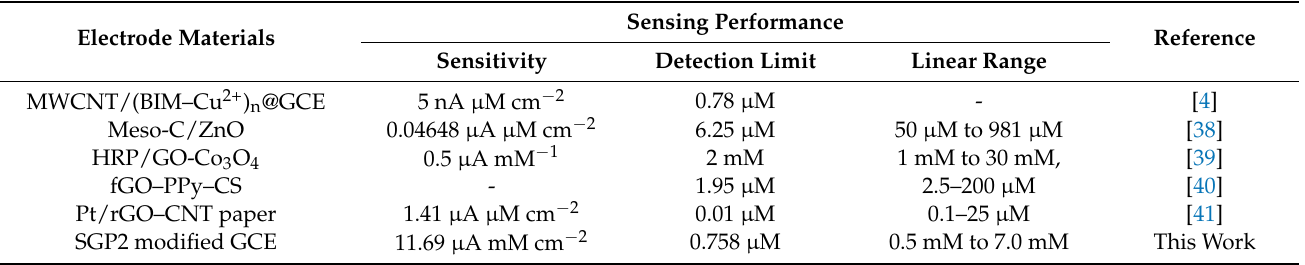
Table 1. Comparison of the electrochemical performance of the fabricated SGP2 modified GCE with previously published sensors for H 2 O 2 detection.